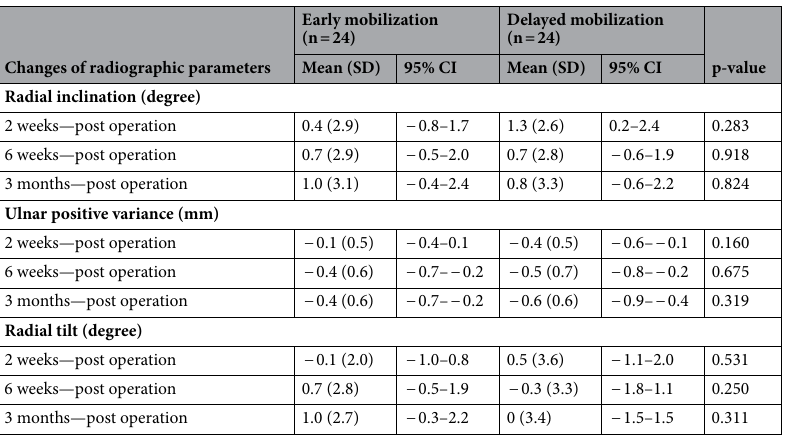
Table 3. Radiographic outcomes. Independent